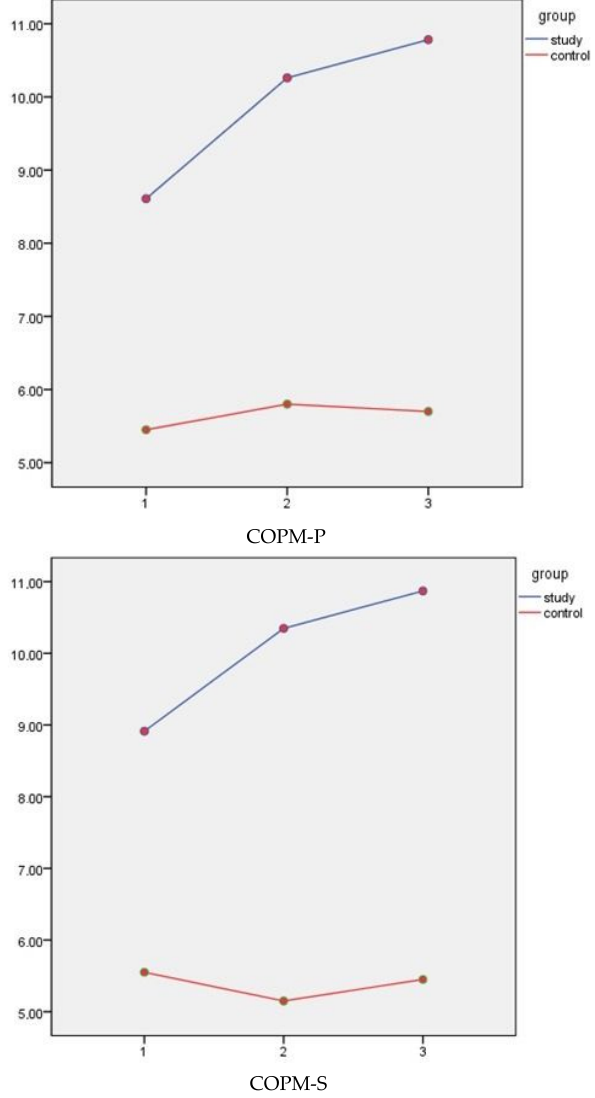
Figure 3. COPM-P and COPM-S graphic of change over time between groups.